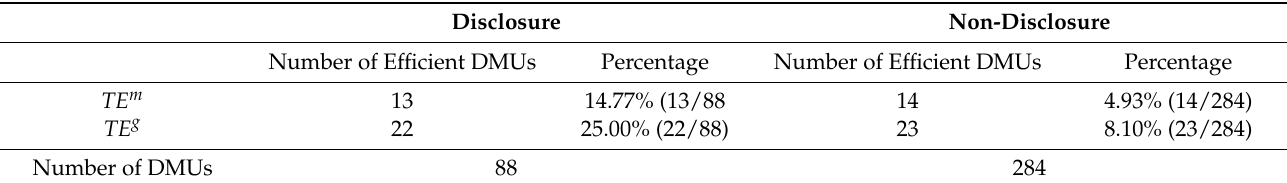
Table 3. Summary of Efficient DMUs Located on the Frontiers.